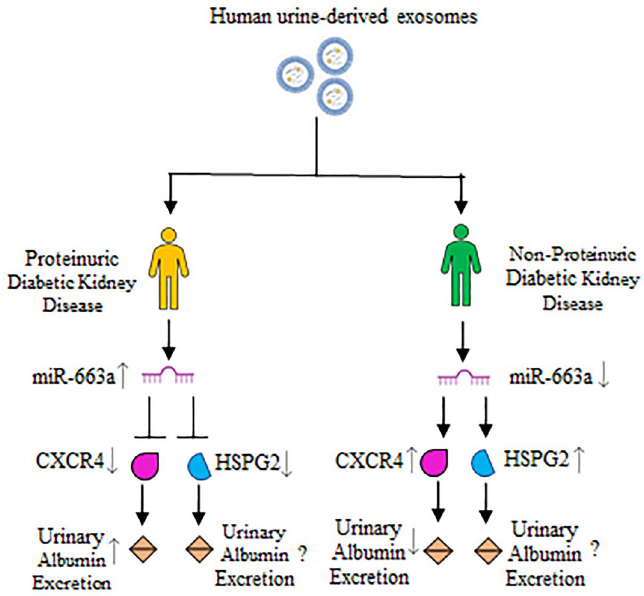
Figure 6. Schematic representation of the proposed hypothesis of the study. According to IPA, increased miR-663a expression reduced CXCR4 and HSPG2 expression (Fig. 6d). As a result, it is possible that elevated miR-663a expression in PDKD reduced CXCR4 expression, leading to albuminuria. Reduced HSPG2 expression was inversely associated with the severity of proteinuria. In the lack of heparan sulfate binding sites, however, there is no proteinuria, but the development of DKD is probable 51 . Reduced expression of miR-663a in